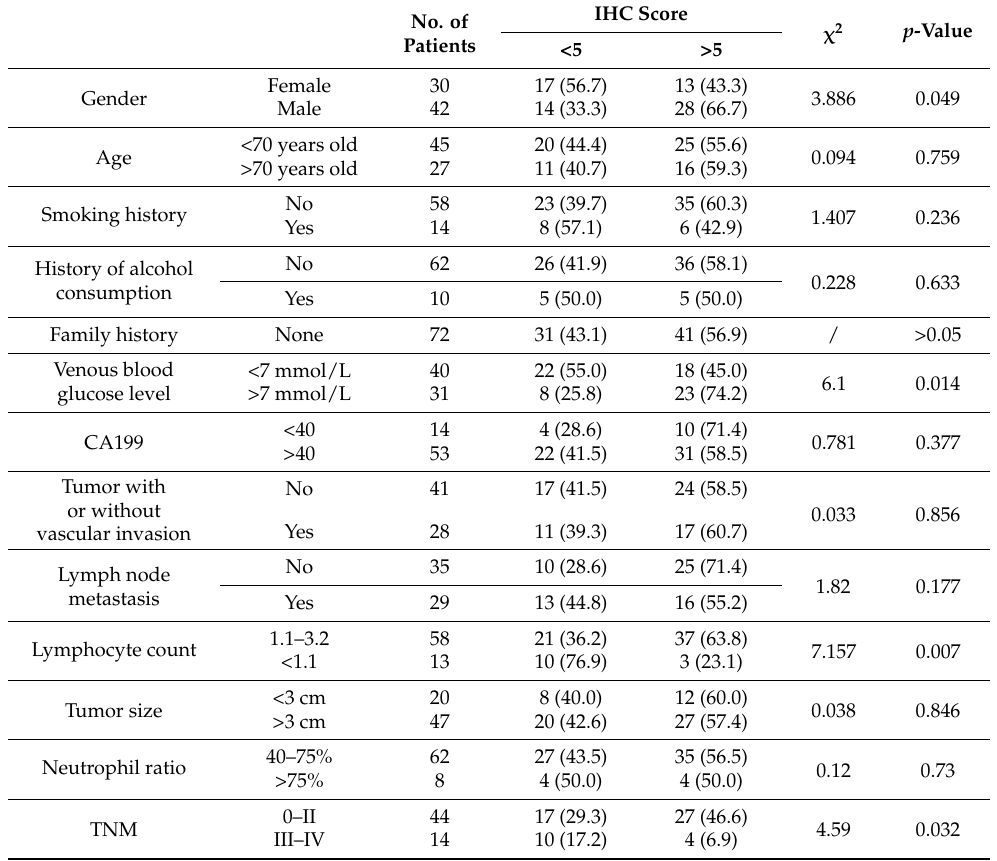
Table 1. Relationship between immunohistochemical scores and the clinicopathological characteris- tics of